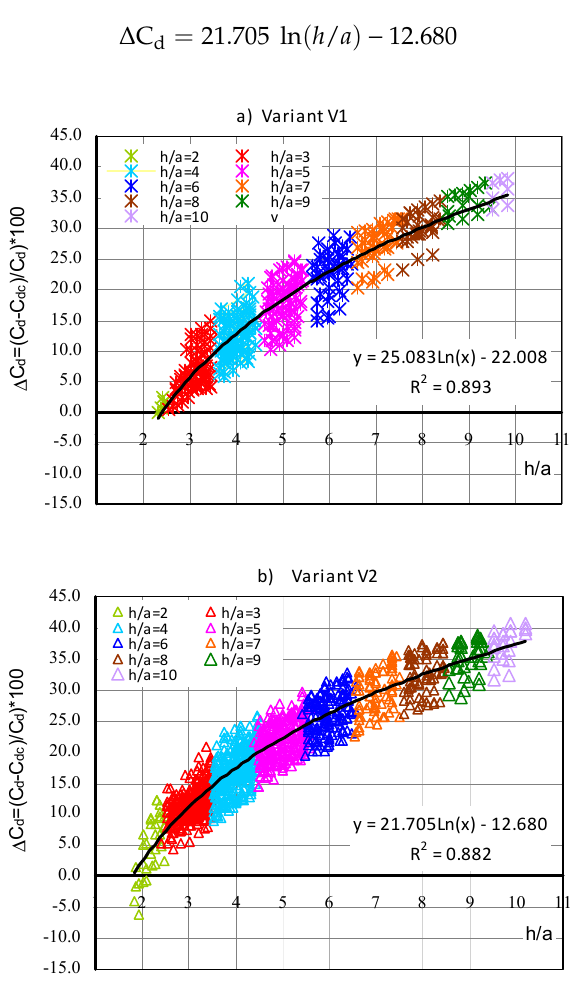
Figure 10. Percentage deviation of the C d discharge coefficients calculated on the basis of measurements from the C dc obtained using relationship (5): ( a ) Case V1, ( b ) Case V2.